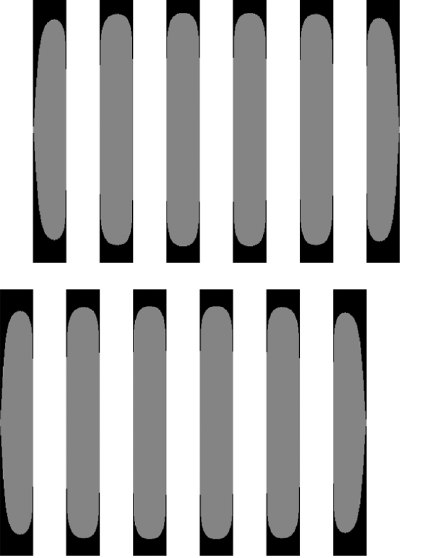
FIG. 5. Cross-sectional view of current distribution (EM method). The black area indicates where the current is flowing. The gray area indicates where the current is not flowing.